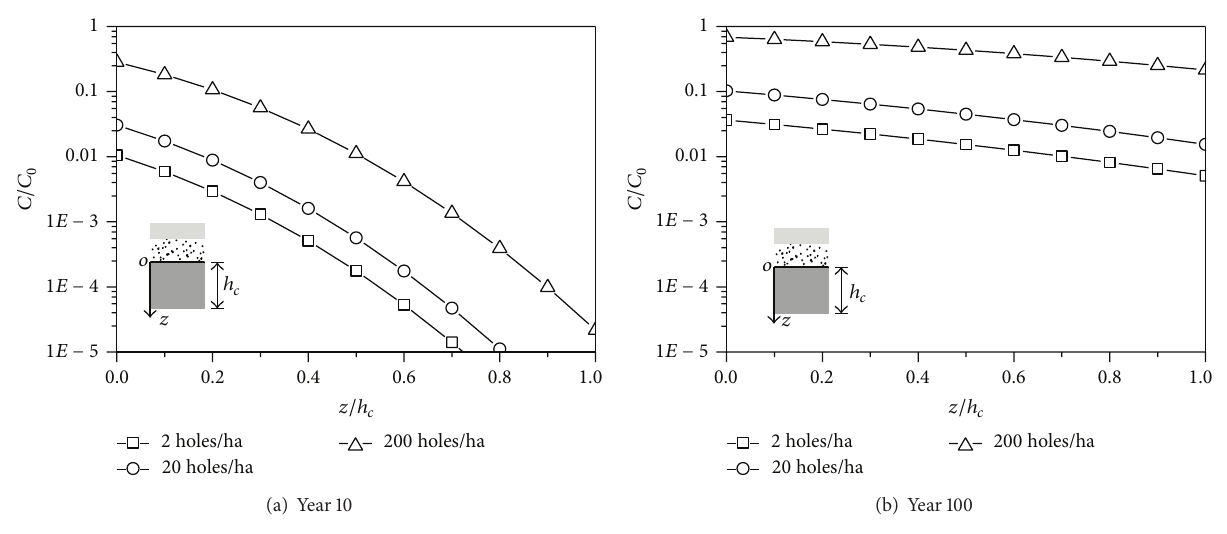
Figure 7: Comparison of numerical results with different GM defect